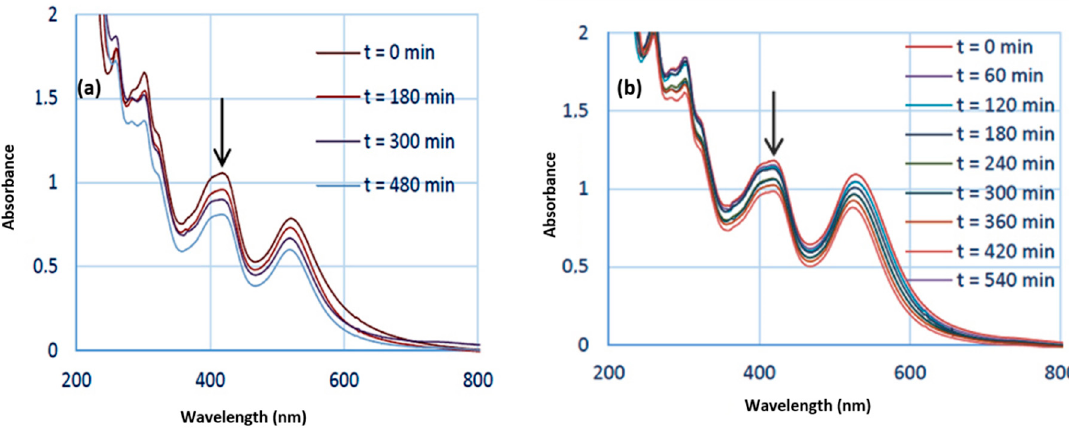
Figure 7. Temporal evolution of the UV-visible spectra of deaerated aqueous solutions containing 5 × 10 − 4 M potassium hexacyanoferrate under LEDs irradiated at 520 nm ( a ) in the presence of 15 nm Au- NPs@citrate and ( b ) 30 nm Au-NPs@citrate. Optical path length: 1 cm.